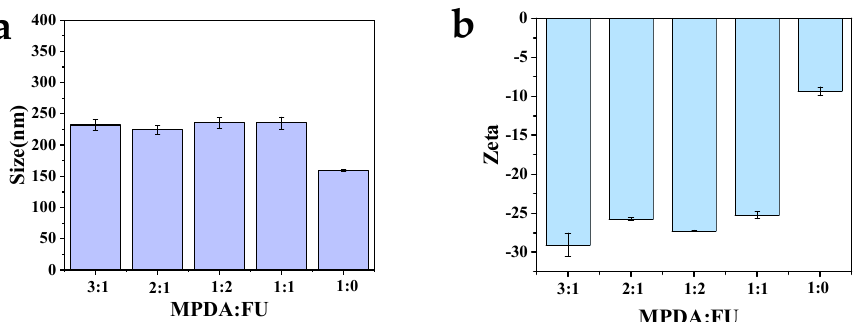
Figure 2. ( a ) Particle size of MPDA − DOX@FU − SS prepared using different ratios of MPDA to fu- coidan (FU). ( b ) Zeta potential of MPDA − DOX@FU − SS prepared using different ratios of MPDA:FU (n = 3, DOX: doxorubicin).